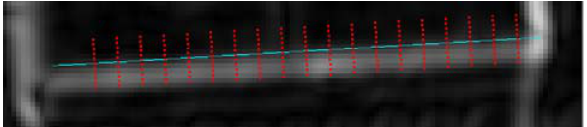
Figure 3. Extracted line segments (blue) and projected 3D building model (yellow) before matching. The model lines with correspondences are marked in green; in red – the extracted line segments with correspondences. The lines were extracted using Sobel filter.